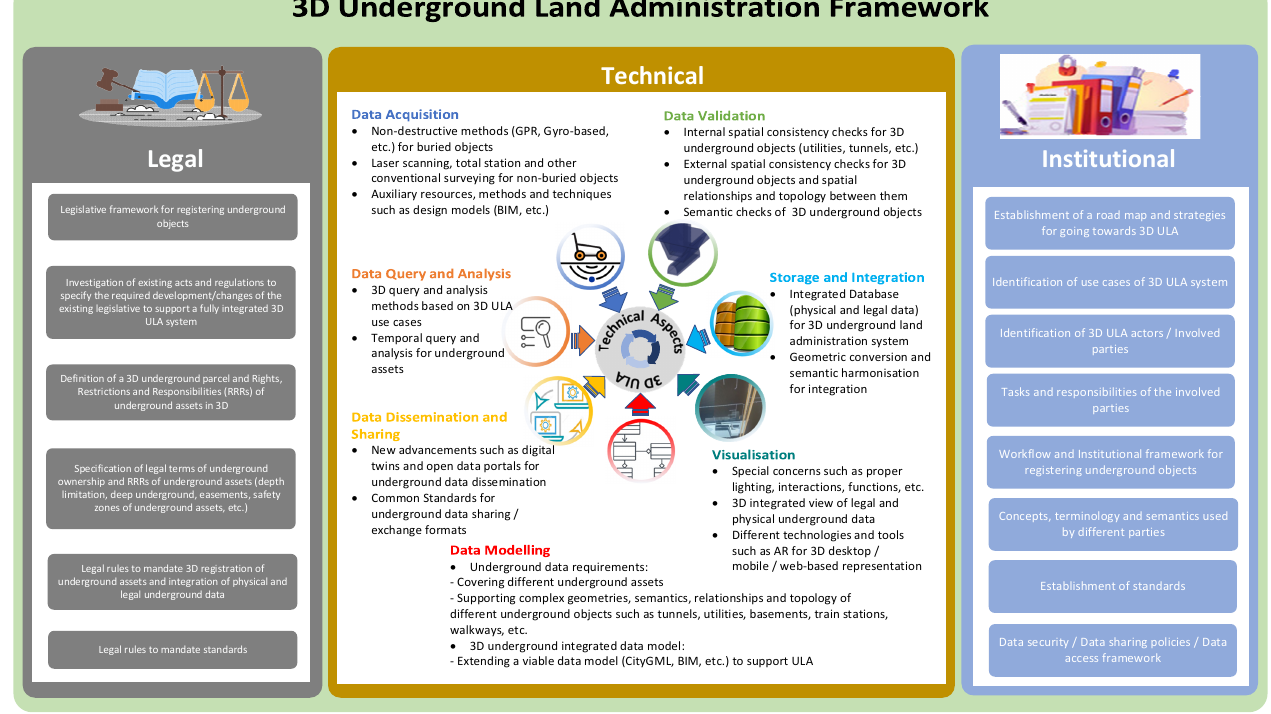
Figure 7. A technical framework as the basis for developing a new ULA system.